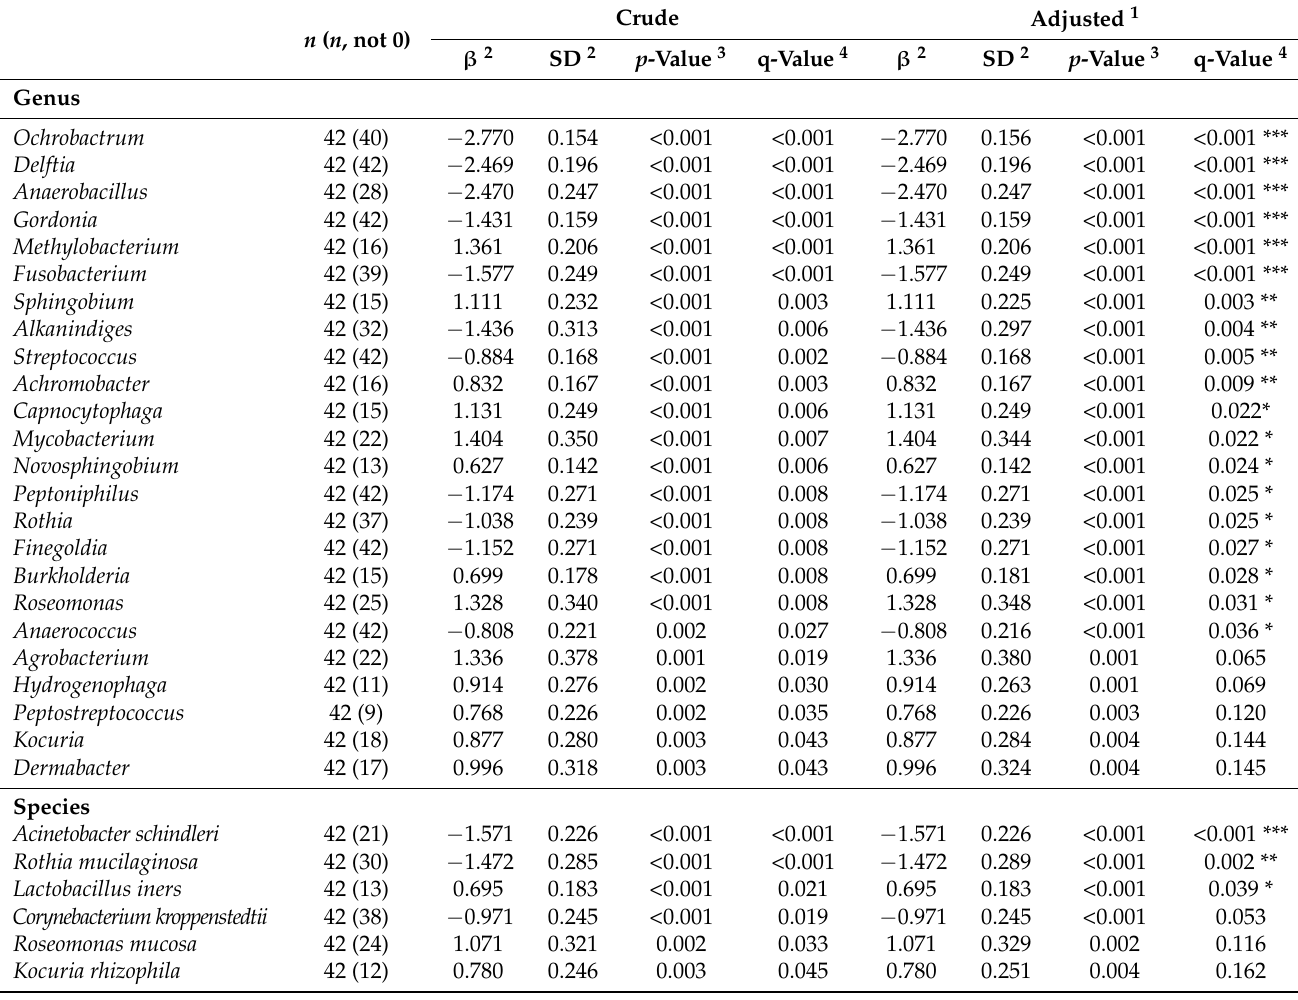
Table 2. Statistically significant (after adjustments and correcting for multiple comparisons) genera and species identified from general linear models for determining multivariable association between sample type, covariates and microbial metagenomic features in paired pus and skin samples from patient with idiopathic granulomatous mastitis